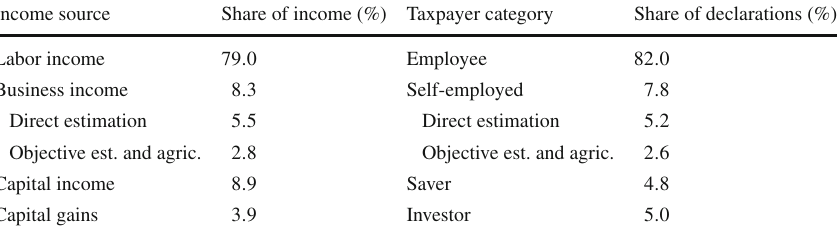
Table 1 Distribution of income by source and taxpayer